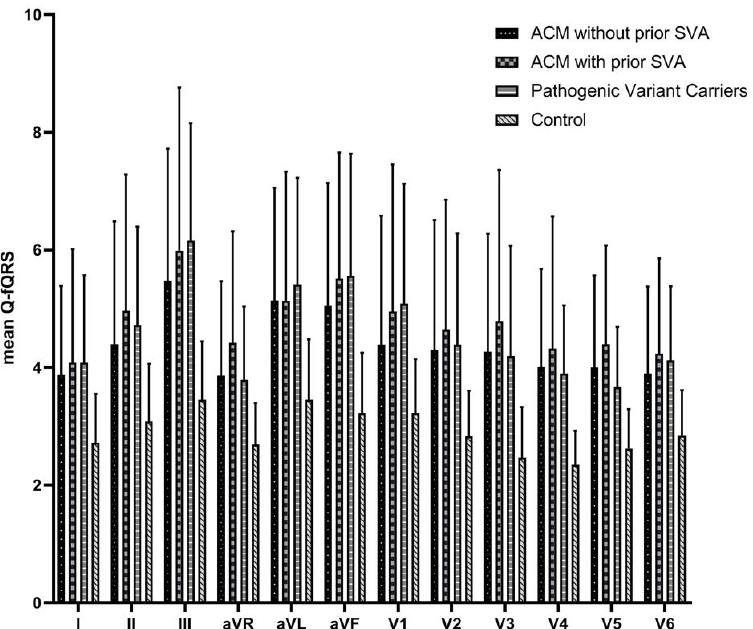
Figure 3. ACM = arrhythmogenic cardiomyopathy; ECG = electrocardiography; fQRS = fragmented QRS; SVA = sustained ventricular arrhythmia. Table 2. Fragmentation of the QRS complex.